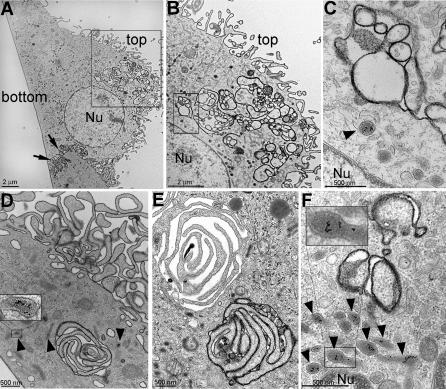
RR Staining of Uninfected MDM Reveals a Complex Plasma Membrane OrganizationMDM were fed with BSA-gold and fixed in the presence of RR.(A) A cell profile at low magnification contacting a neighboring cell. The smooth left side was previously attached to the substrate (indicated as “bottom”); the right side displaying many RR-positive protrusions is the side facing the extracellular medium (“top”). Seemingly intracellular structures also appear RR-positive. At the tight-fitting contact zones between two cells (arrows) the stain appears more electron-dense than on single lipid bilayers.(B) Higher magnification of the boxed area in (A) showing the collection of vacuolar-like invaginations stained with RR.(C) Higher magnification of the boxed area in (B) showing a RR-positive structure next to a BSA-gold-filled endosome (arrowhead).(D) Comparison of RR-positive cell surface protrusions and similar RR-positive protrusions, which appeared intracellular in this section. Arrowheads indicate gold-filled endosomes. The inset in (D) shows an enlargement of a BSA-gold-filled endosome in the boxed area.(E) Two identical looking structures with stacked protrusions; in the upper one the membranes are not RR-stained, indicating that not all vacuolar structures are accessible to the stain.(F) A collection of BSA-gold-filled endosomes (arrowheads) next to RR-stained vacuolar structures to emphasize the differences in size and morphology. The inset in (F) shows an enlargement of a BSA-gold-filled endosome in the boxed area. Nu, nucleus. Bars, 2 μm (A and B) and 500 nm (C–F).